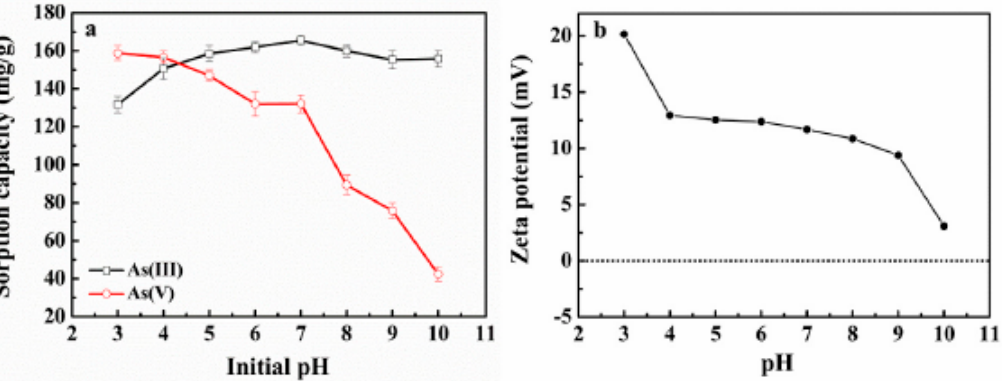
Figure 3. ( a ) The adsorption capacity of As species on Fe 2 Co 1 MOF-74 under different pH, ( b ) The zeta potential variations of Fe 2 Co 1 MOF-74 with pH variation. Temperature = 25 ◦ C, adsorbent dose = 0.5 g/L, initial arsenic concentration = 100 mg/L. (Reproduced with permission from Ref. [59] with permission from Elsevier, 2019).